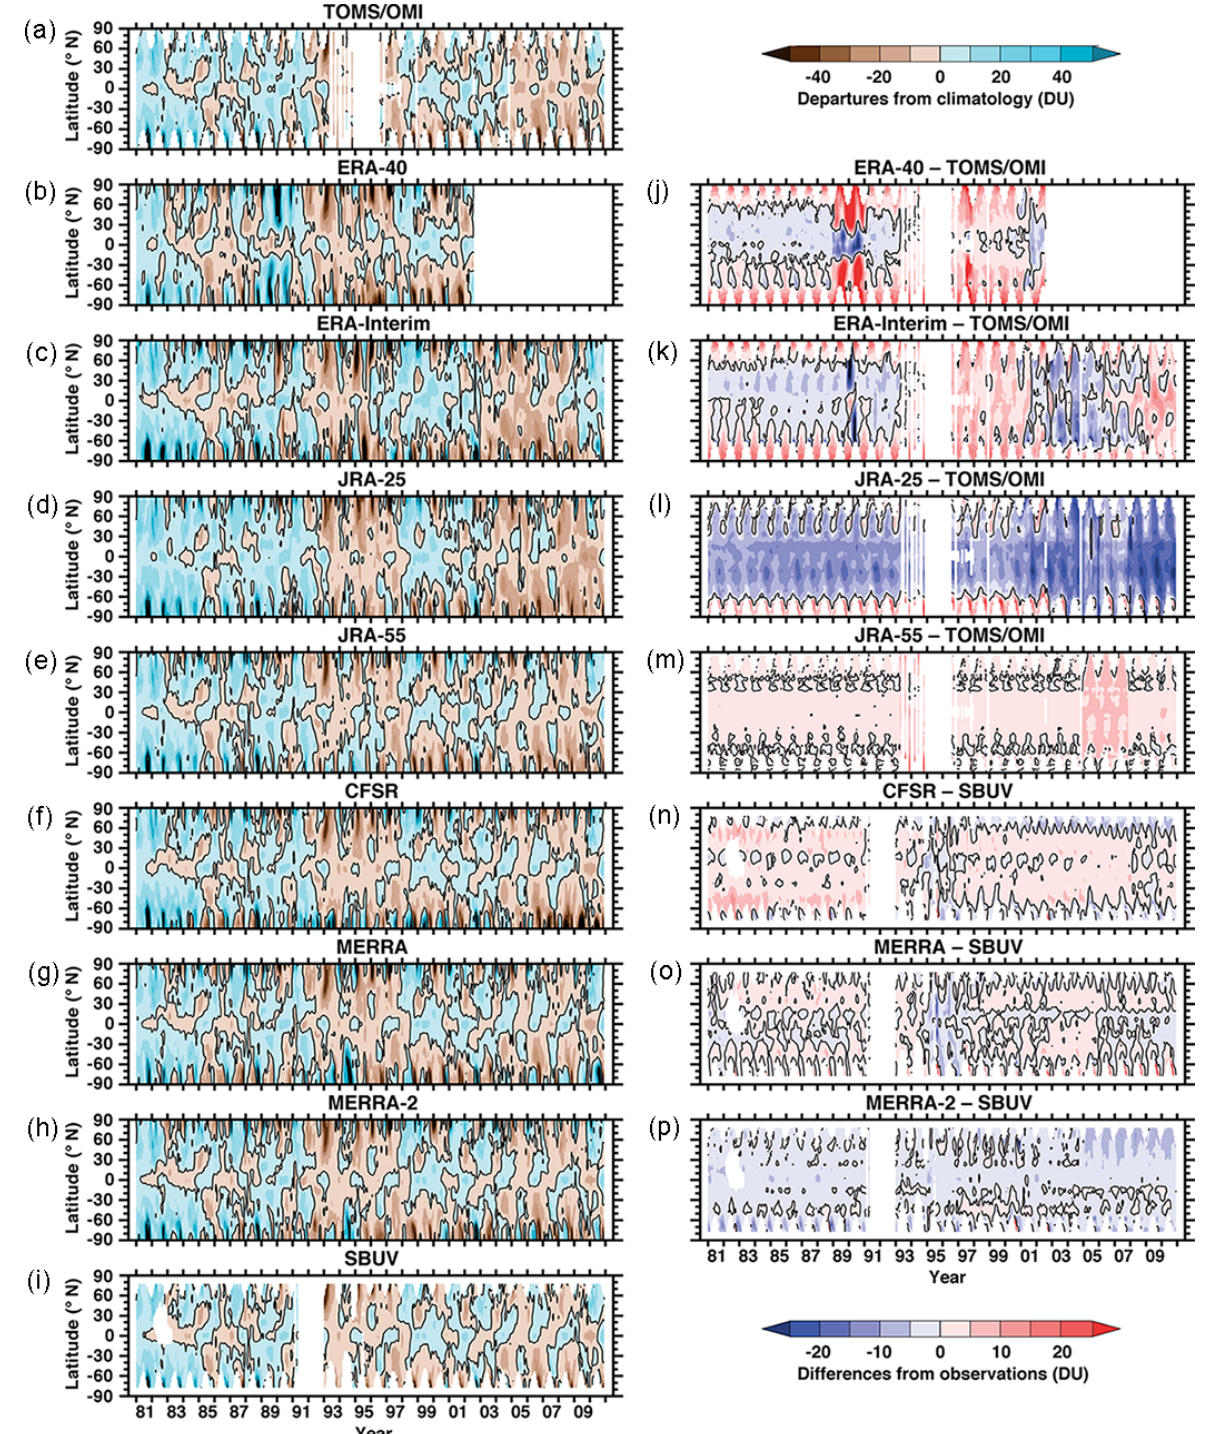
Figure 10. Departures of TCO from the zonal- and monthly mean 1981–2010 climatology for TOMS/OMI (left column, top row), SBUV (left column, bottom row), and reanalyses (left column, other rows). Right column: differences between reanalyses’ zonal and monthly mean TCO and the primary TCO observations that they assimilate. The black contour is at